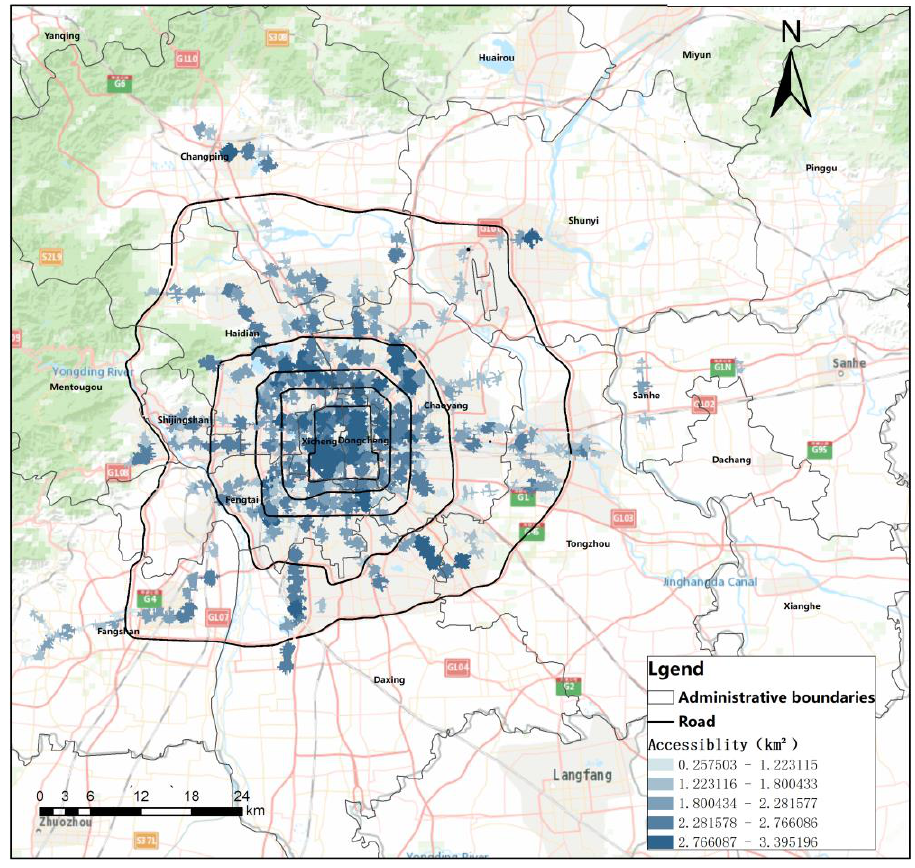
Figure 3. Distribution of rail transit station area accessibility in Beijing.